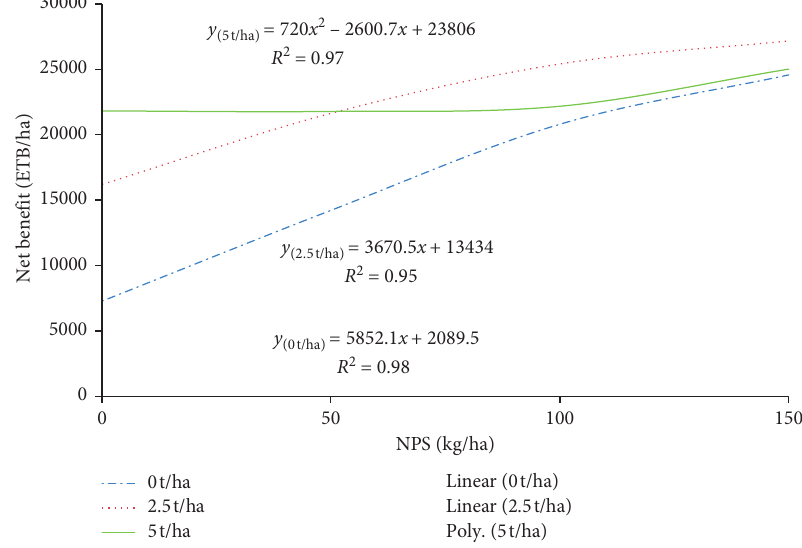
Figure 4: Net return of haricot bean as affected by interaction effects of NPS and organic